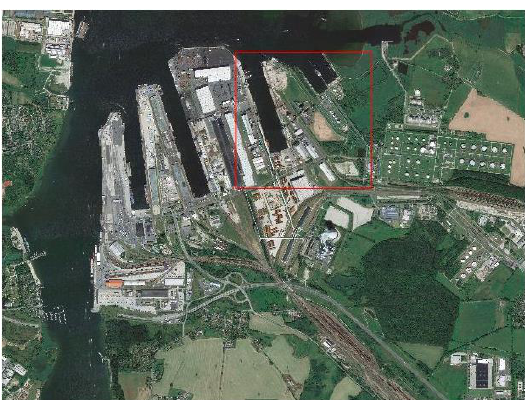
Figure 13. Detection on Rostock Port in Germany by SIFT- based keypoint matching